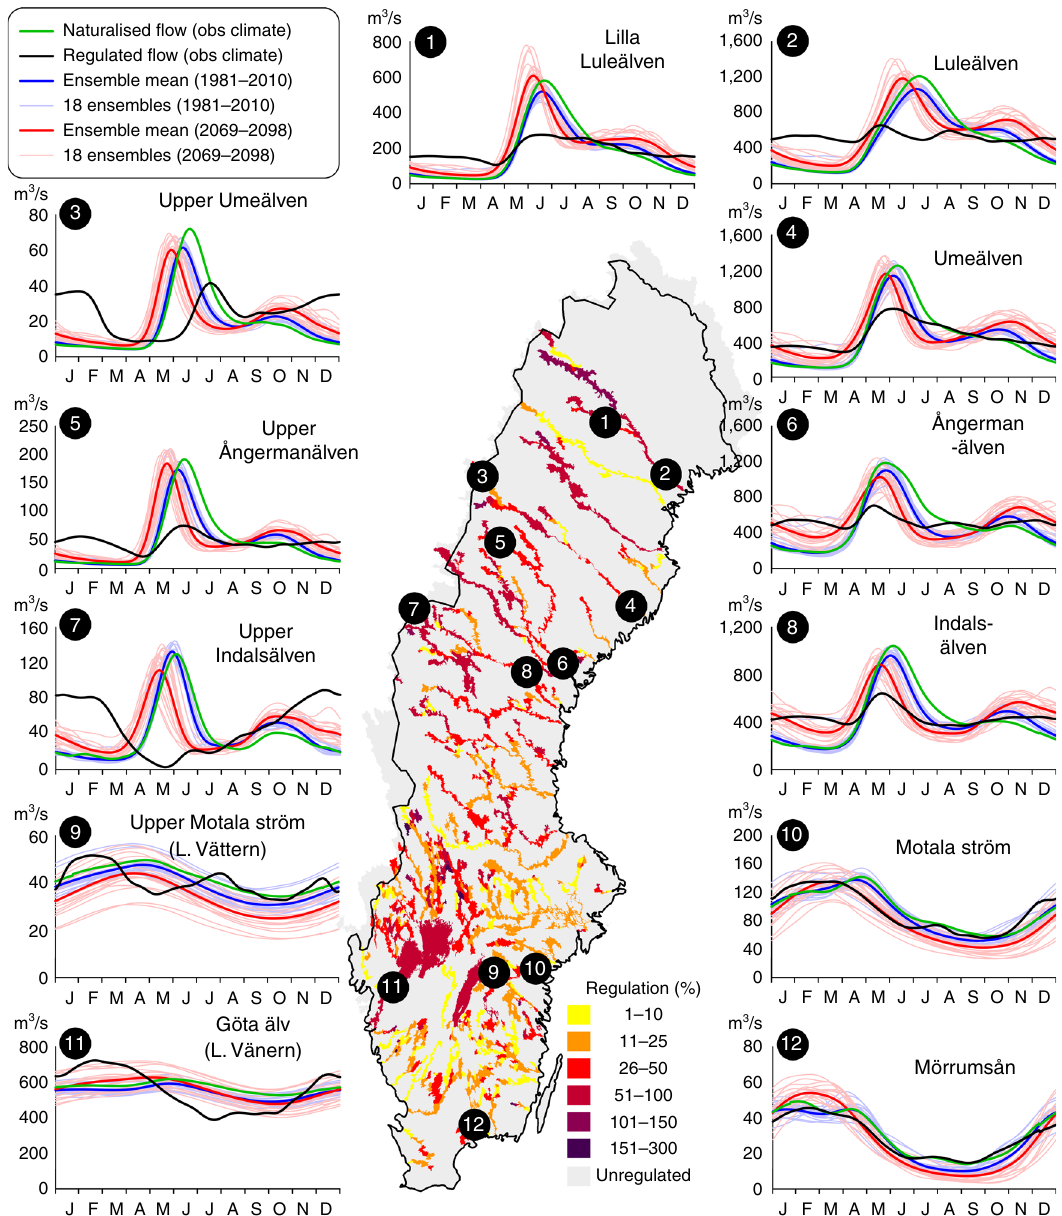
Fig. 3 Spatial variability of impact from regulation and climate change on local fl ow regime. Seasonal fl ow regimes in 12 regulated Swedish Rivers under present conditions ( black line ) and under naturalised conditions with observed climate ( green ) or projections from climate models ( blue and red ). Smoothed daily mean values are shown for 30-yr period and the sites have an average regulation degree of 48% (range 25 – 75%). The map shows the calculated accumulated degree of hydropower regulation in Swedish rivers. The climate impact modelling was based on CMIP5 projections for the RCP 4.5 and 8.5 from: CanESM2, CNRM-CM5, GFDL-ESM2M, EC-EARTH, IPSL-CM5A-MR, MIROC5, MPI-EMS-LR, NorESM1-M, HadGEM2-ES. Each ensemble